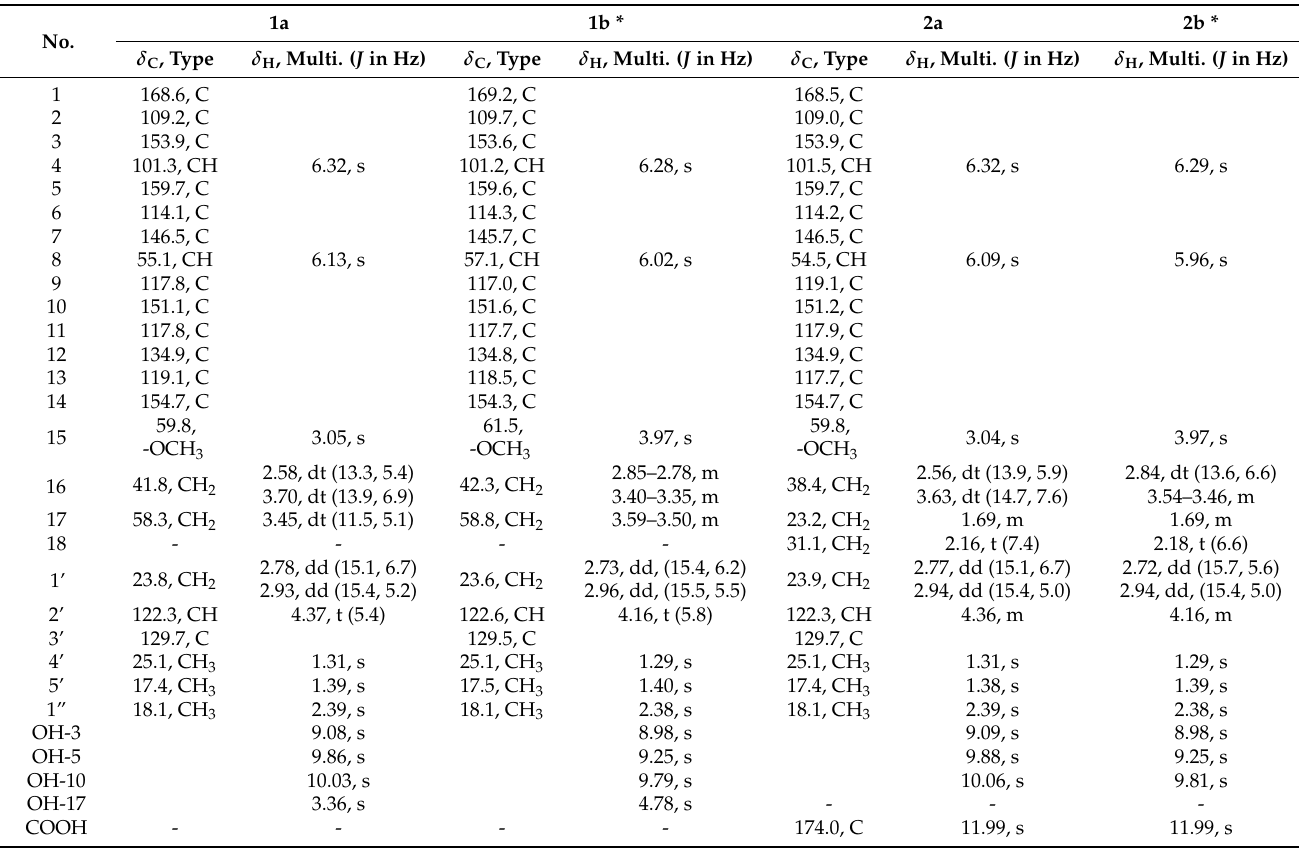
Table 1. 1 H and 13 C NMR data of pestalachlorides A1a ( 1a )/A1b ( 1b ) and A2b ( 2a )/A2b ( 2b ) in DMSO- d 6 .